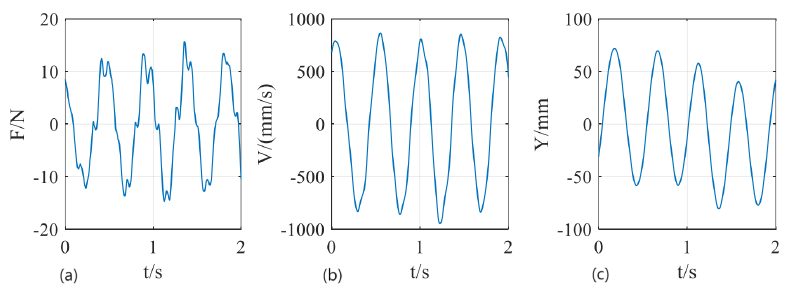
Figure 15. High dynamic performance motion test of dragging operation: ( a ) contact force; ( b ) robot velocity; ( c ) robot position.